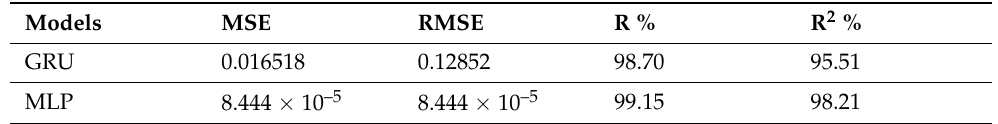
Table 2. Results of the GRU and MLP models during the training process.